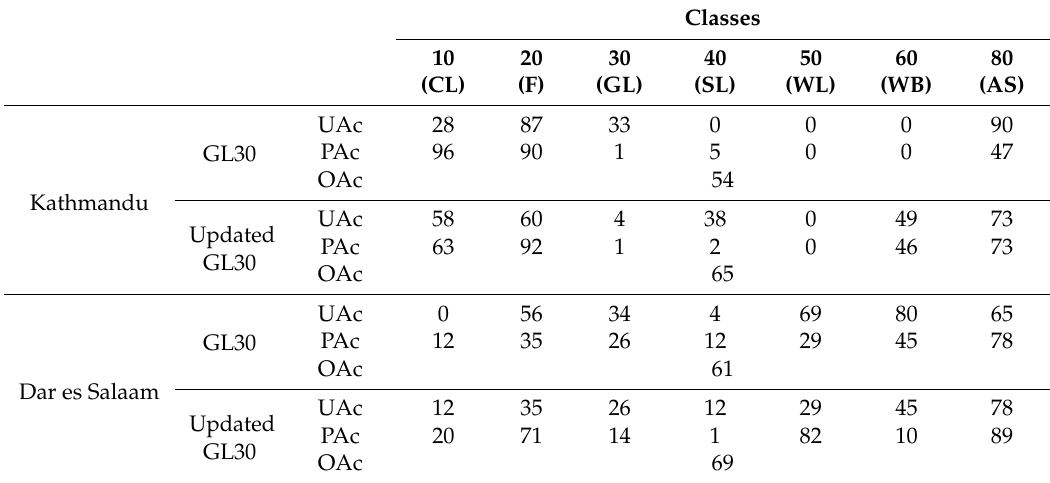
Table 10. User’s accuracy (UAc), producer’s accuracy (PAc) and overall accuracy (OAc) obtained for the GL30 and updated GL30 for both study